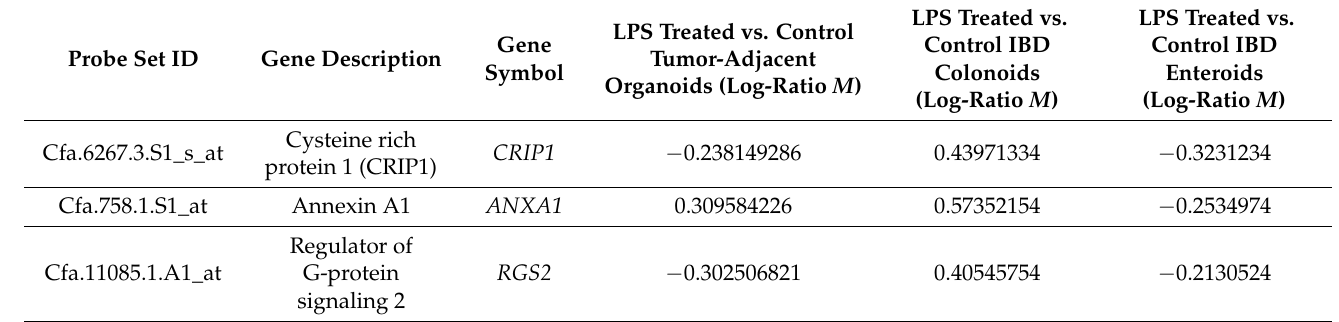
Table 14. The list of genes in the same or the opposite direction (upregulated in IBD enteri- ods/colonoids and downregulated in tumor-adjacent organoids and vice versa) between the IBD enteroids/colonoids and tumor-adjacent organoids following LPS stimulation. The log-ratio M values represent the log(R/G) (log fold change) [44].